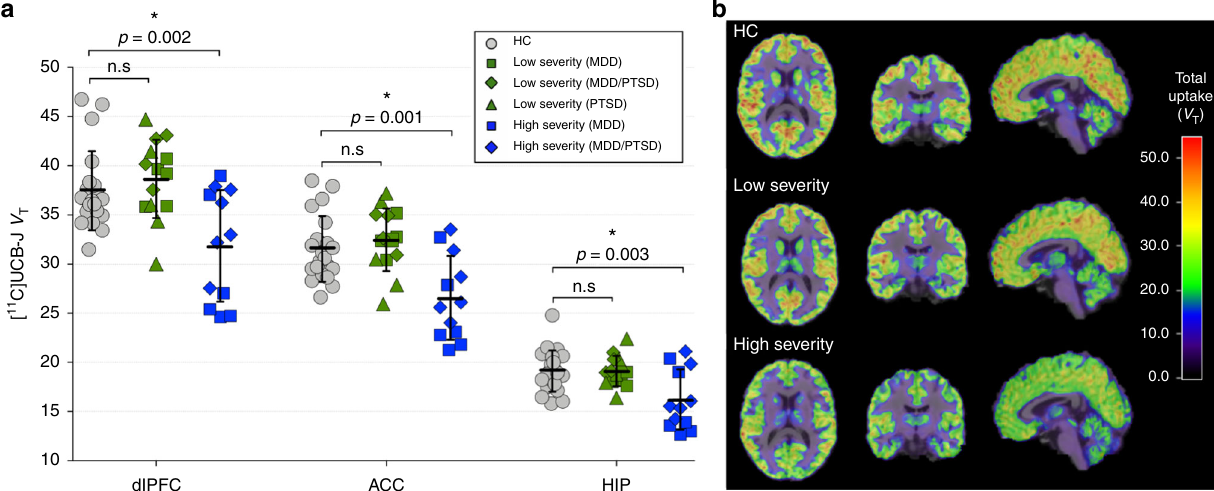
Fig. 2 Lower SV2A density in individuals with high severity depressive symptoms vs. HC subjects. a [ 11 C]UCB-J V T in the dlPFC, ACC, and hippocampus across groups. The low severity group (in green; n = 14) consisted of participants with HAMD-17 scores <14 and the high severity group (in blue; n = 12) consisted of participants with HAMD-17 scores ≥ 14. Clinical subgroups are represented by different symbols; the low severity group consisted of MDD ( n = 5), PTSD ( n = 5) and MDD/PTSD ( n = 4) subjects; the high severity group consisted of MDD ( n = 6) and MDD/PTSD ( n = 6) subjects. Group differences were assessed using MANOVA. Error bars represent standard deviation. b Representative axial, coronal, and sagittal parametric images of [ 11 C] UCB-J PET ( V T ) scans registered to MR images in MNI space from a HC participant (top), low severity subject (middle) and high severity subject (bottom). Color bar represents V T. dlPFC: dorsolateral prefrontal cortex: dlPFC, ACC:anterior cingulate cortex Group differences in synaptic density . There were no signi fi cant (depression factor — dlPFC: r = − 0.49, p = 0.019; ACC: r = − 0.43, p = 0.028; hippocampus: r = − 0.40, p = 0.044; somatic differences in [ 11 C]UCB-J V T (SV2A density) between the full clinical sample ( n = 26) and HCs ( n = 21) across the primary factor — dlPFC: r = − 0.62, p = 0.001; ACC: r = − 0.60, p = 0.001; ROIs (dlPFC, ACC, hippocampus) (MANOVA: F 3,43 = 1.88, p = hippocampus: r = − 0.45, p = 0.020; insomnia factor — dlPFC: r = − 0.50, p = 0.009; ACC: r = − 0.46, p = 0.018; hippocampus: r = 0.147). In the MDD only sample ( n = 11), a MANOVA indicated − 0.39, p = 0.046). No associations were observed with the anxiety lower synaptic density across primary ROIs compared to the HC group (F 3,28 = 3.67, p = 0.024), with the hippocampus surviving factor. There were no signi fi cant correlations between [ 11 C]UCB- J V T and PTSD symptoms (PCL-S; see Supplementary Notes). corrections for multiple comparisons (17% lower, p = 0.002).